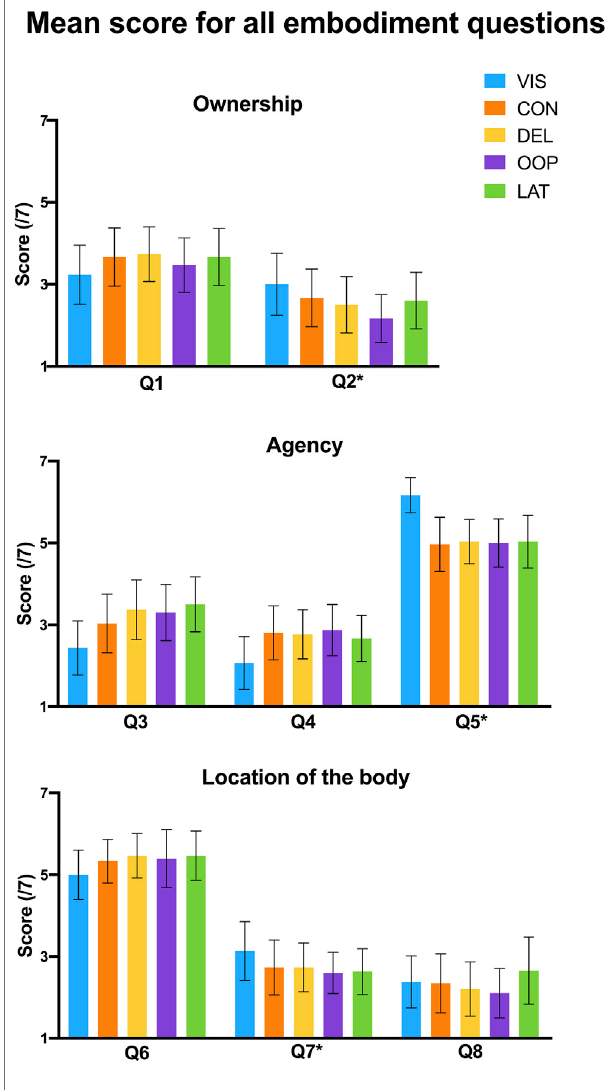
FIGURE 6 | Mean score ( N (cid:2) 30 participants) and 95% interval limits obtained in the second phase of the experiment, for all questions of the embodimentquestionnaire,groupedbyembodimentcomponent.VIS,Visual- only condition (no vibration); CON, congruent condition; DEL, delayed condition; OOP, out-of-phase condition; LAT, lateralized condition. *Indicates a question that is scored negatively (a lower value is indicative of a stronger sensation in the related embodiment